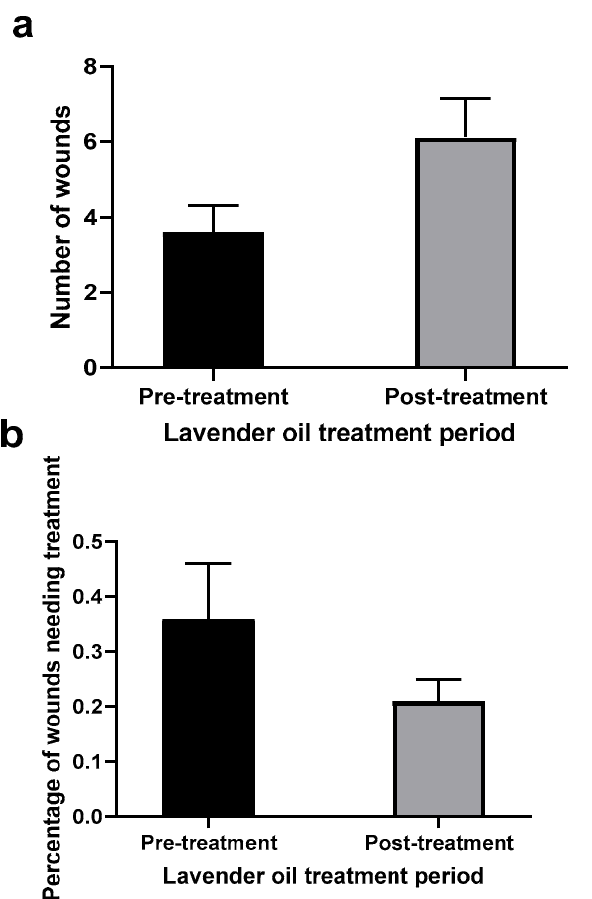
Figure 2. The number of overall wounds increased during lavender treatment compared to pre- treatment ( p = 0.01). ( a ) While overall wounding increased post-treatment, ( b ) the percentage of wounds requiring treatment decreased following initiation of lavender therapy ( p = 0.02).